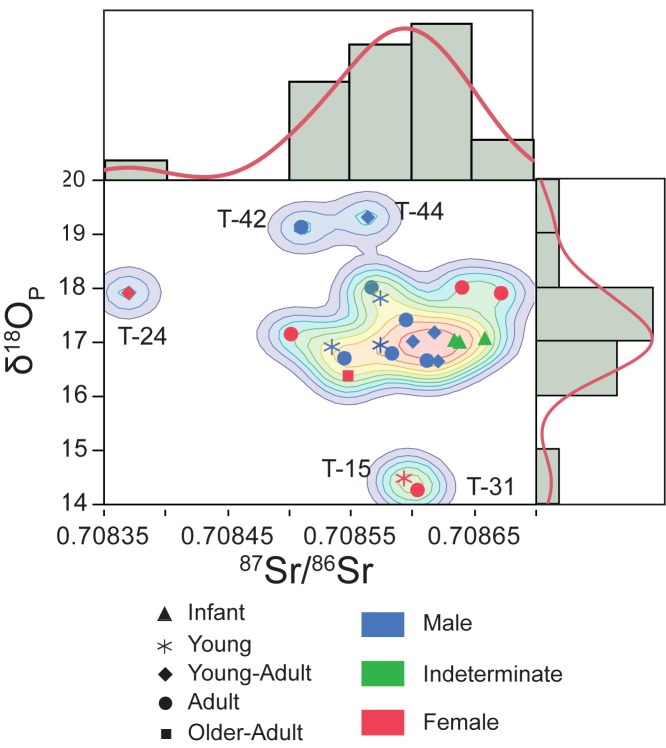
δ18O versus 87Sr/86Sr in the tooth enamel of Tauste individuals.Kernel density contour lines represent 10%.